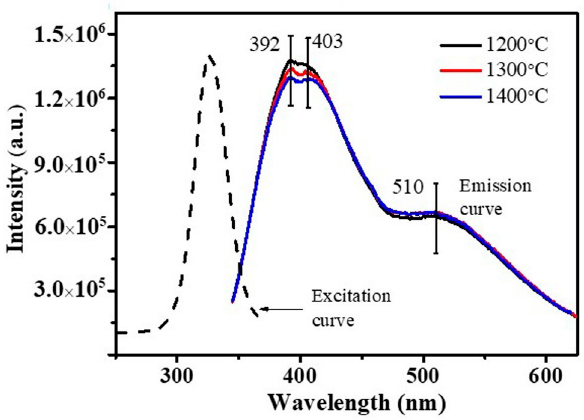
Figure 8. Emission spectra of SiC/SiO 2 heterojunctions synthesized at different temperatures.